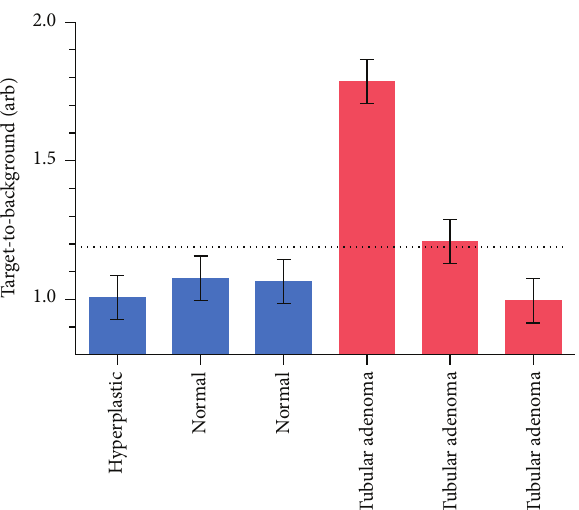
Figure 5: ICG TBRs for all polyps identified and biopsied in the clinical trial. Horizontal dotted line = TBR cutoff of